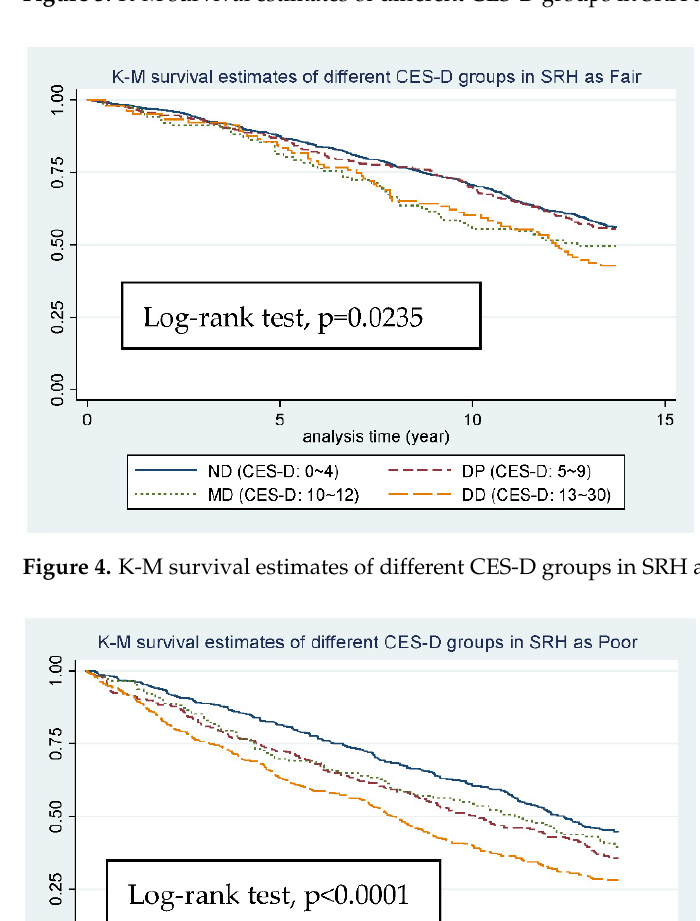
Figure 3. K-M survival estimates of different CES-D groups in SRH as Good.